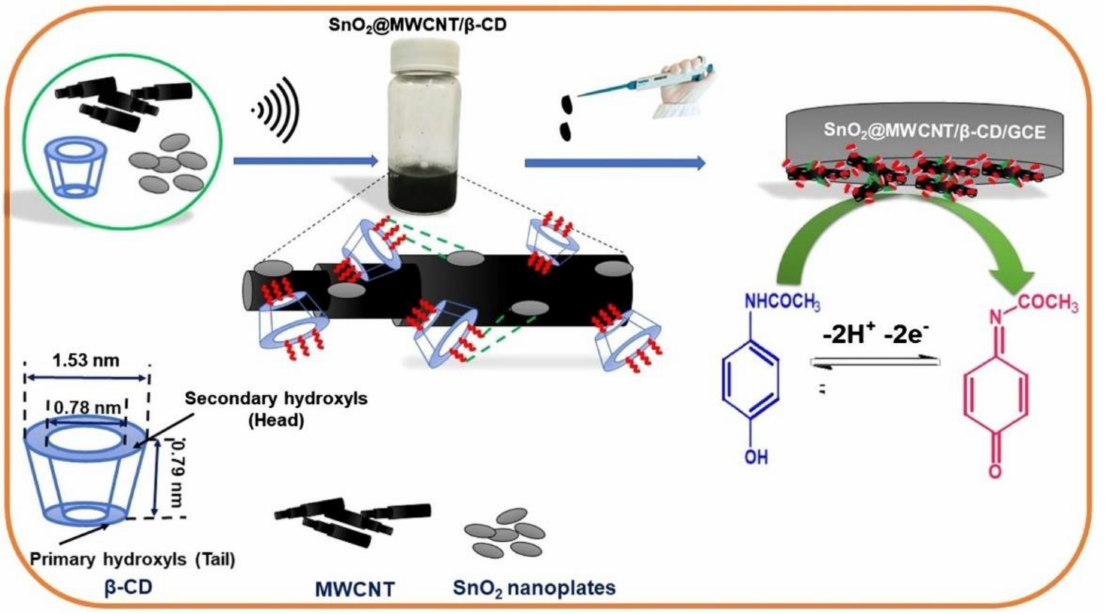
Figure 10. Scheme of the sensor development: materials employed, techniques for dispersion of the nanomaterials, deposition technique, and detection mechanism. Reprinted from [196] with permission of